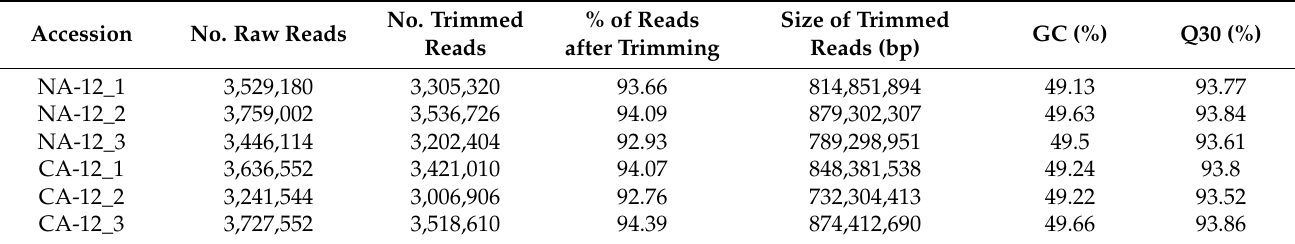
Table 1. Sequencing output statistics of A. turgidum from this study.